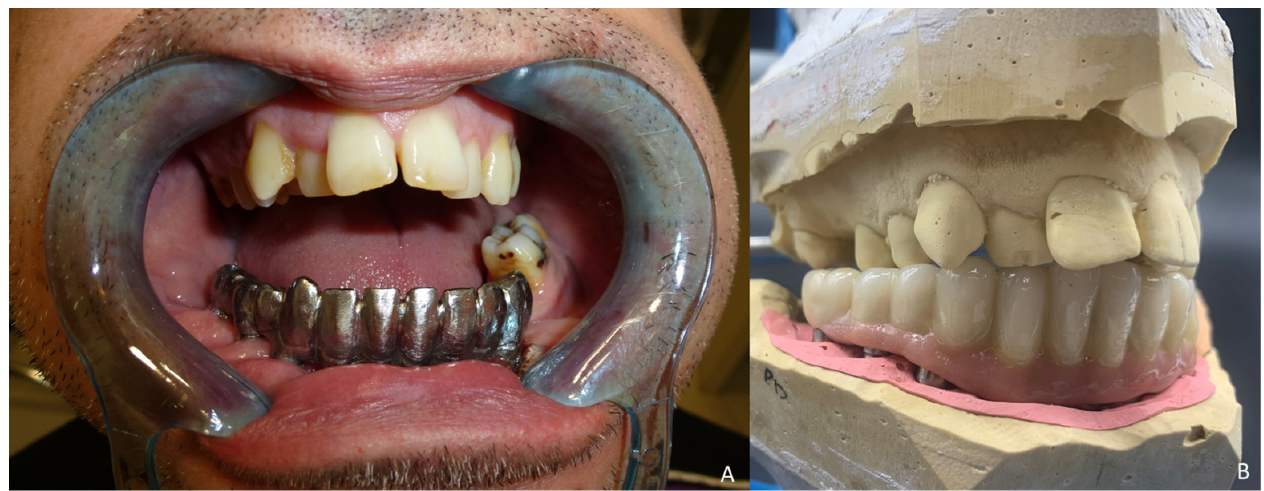
Figure 10. Implant prosthesis. ( A ) Metal framework evaluated intraorally. ( B ) Functional rehabilitation with a ceramic fixed implant-supported prosthesis. J. Clin. Med. 2021 , 10 , x FOR PEER REVIEW